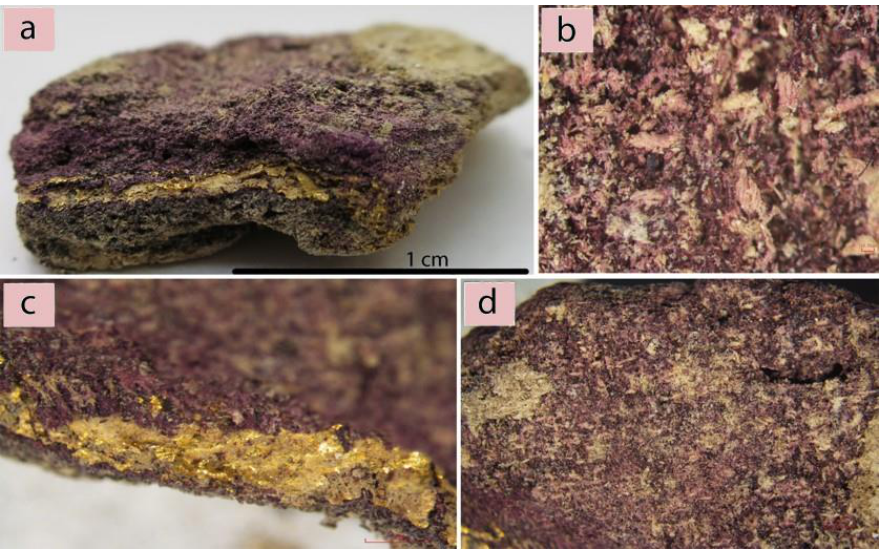
Figure 1. ( a ) The analyzed sample; ( b ) Mineralized structure of a textile with purple dye remains; ( c ) Purple dye and gold strip evidence; ( d ) A purple area on the surface of the